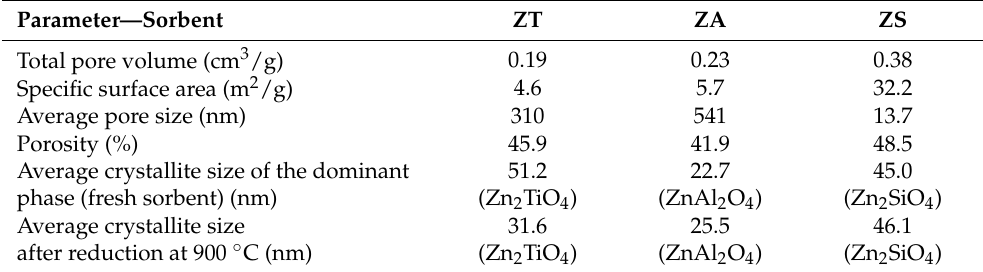
Table 1. The specific surface area, total porosity and the average crystallite size of the dominant phase for sorbents: ZT, ZA,